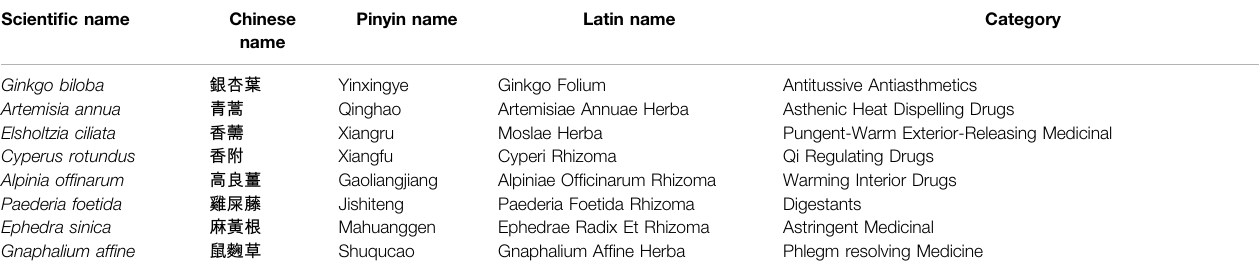
TABLE 2 | ( Continued ) The scienti fi c name, Chinese name, and therapeutic category of the TCM candidates predicted to have anti-SARS-CoV-2